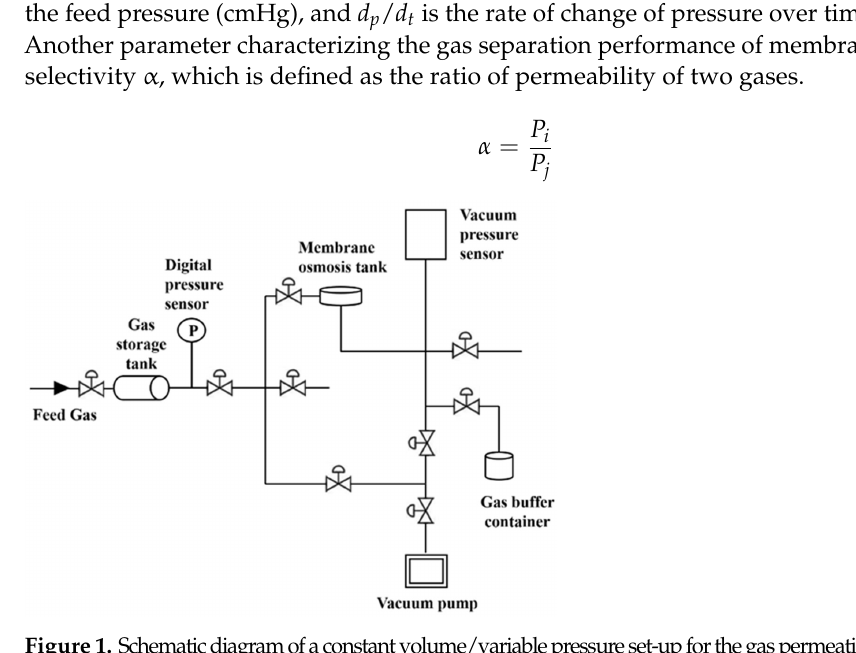
Figure 1. Schematic diagram of a constant volume/variable pressure set ‐ up for the gas permeation Figure 1. measurement.